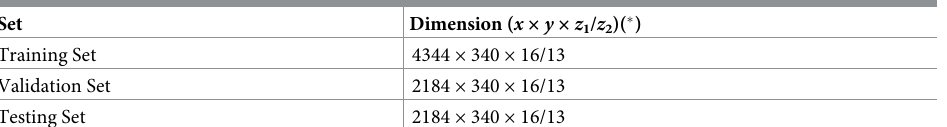
Table 3. The dimension of each sets.